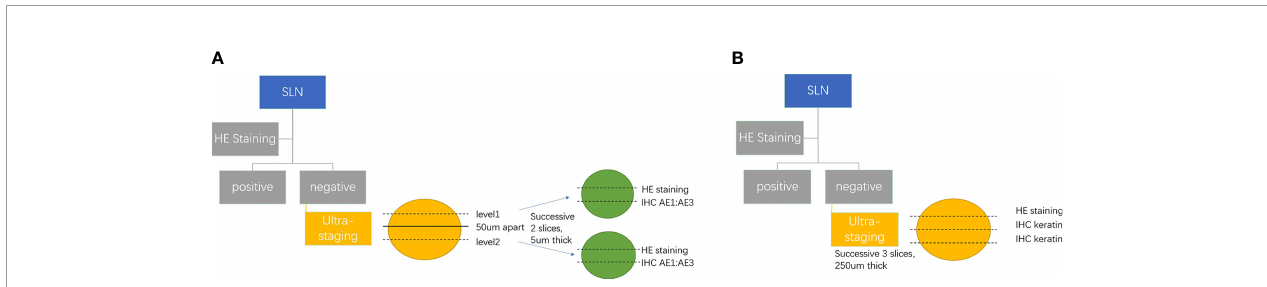
FIGURE 2 | (A) MSKCC SLN ultra-staging protocol. (B) M.D. Anderson Cancer Center SLN ultra-staging